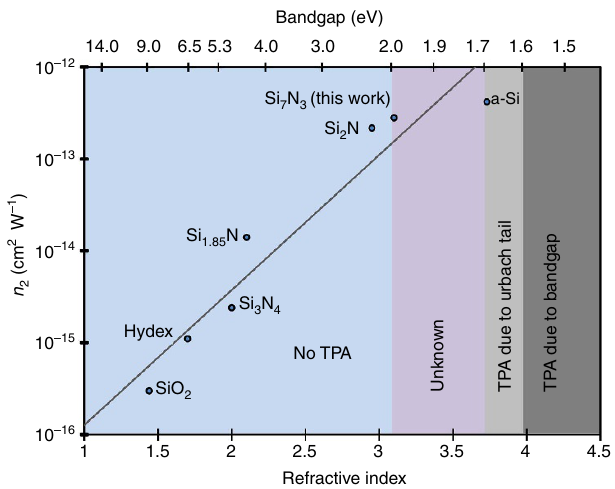
Figure 1 | List of CMOS amorphous solids on a refractive index scale. Values are taken from refs 13,20,28,29,33–40,43,50,53,55,65,66. The nonlinear refractive index and bandgap energies for each material follow a scaling rule as indicated by the grey solid line as a guide to the eye. The bandgap relation to the refractive index is fitted empirically with reported values. Materials in grey reside in the two-photon absorption (TPA) regime at 1,550nm. NATURE COMMUNICATIONS|8:13878|DOI: